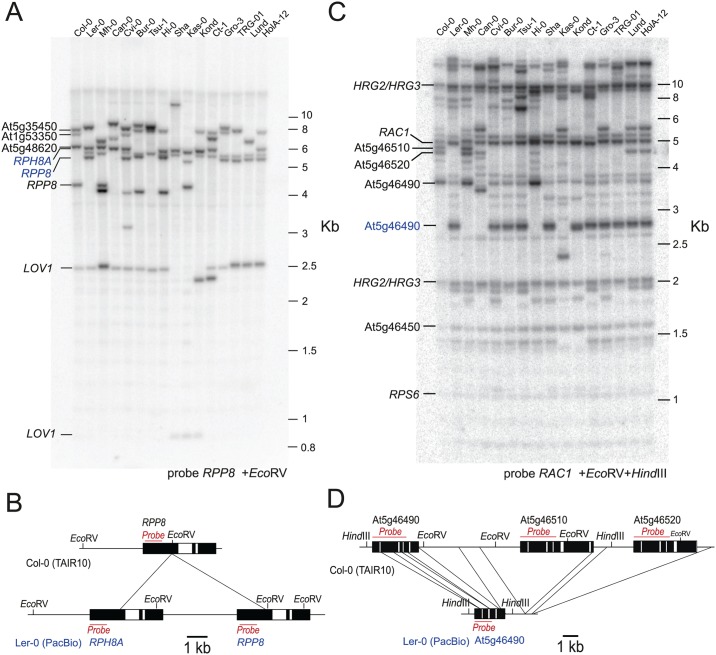
NBS-LRR gene structural diversity between Arabidopsis accessions.(A) Southern blotting and hybridization analysis of RPP8 in the indicated accessions. Cross-hybridizing NBS-LRR genes in Col-0 predicted from the TAIR10 reference assembly are labelled in black. In Col-0 RPP8 is detected as a 4.3 kb EcoRV band, and two 5.5 and 6.1 kb bands in Ler-0. Bands corresponding to Ler-0 RPP8 and RPPH8A genes are labelled in blue. (B) Diagram showing annotated structural variation at RPP8 between Col-0 (TAIR10) and Ler-0 (PacBio) assemblies [94]. Regions predicted to cross-hybridize with the probe are indicated in red, in addition to the position of EcoRV sites. (C) and (D) are as for (A) and (B), but probing for RAC1. The RAC1 probe cross-hybridizes with a linked cluster of NBS-LRR genes, including RPS6. In Col-0 the RPS6 cluster includes three NBS-LRR genes (At5g46490, At5g46510, At5g46520) that are present as a single gene (At5g46490) in Ler-0; such that in Col-0 three bands of 3.7, 4.5 and 4.7 kb are detected after EcoRV and HindIII digestion, and one 2.8 kb band in Ler-0. The Ler-0 band is labelled in blue.